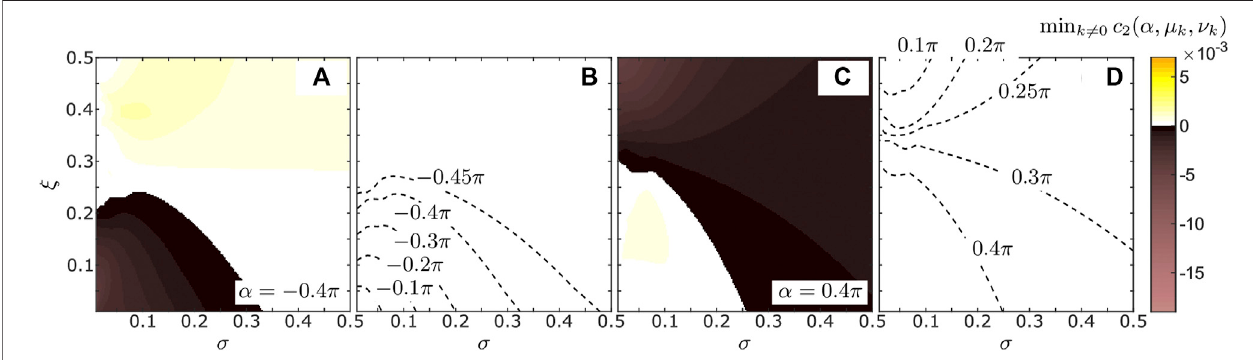
FIGURE5| Stability analysisofthesynchronousstate ofsystem Eqs. 16 , 17 withplasticity rule Eqs. 18 – 20 and coupling structure Eq. 28 .Panels (A, C) show the minimumoverall k ≠ 0 < N of c 2 ,se Eq.15 ,fortwodifferentvaluesof α dependingonthemeanvalue ξ andthestandarddeviation σ oftheweightdistribution.Theminima are displayed in color code. Panels (B, D) show the boundaries between stable and unstable regions in ( σ , ξ ) - plane for different values of α as given in the fi gure. Parameters: (A) N (cid:1) 400, α (cid:1) − 0 . 4 π , (C) N (cid:1) 400, α (cid:1) 0 . 4 π , (B, C) N (cid:1)